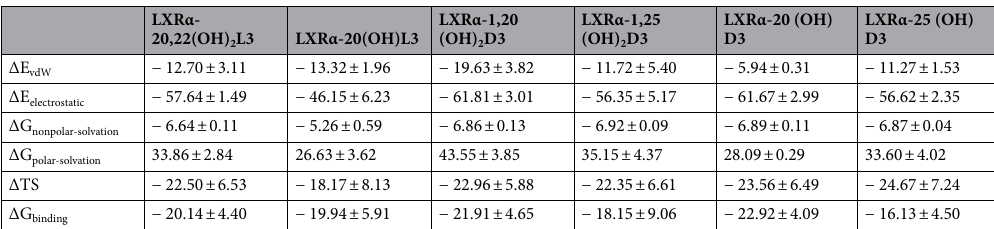
Table 3. Binding free energy between LXRα and D3 or L3 derivatives